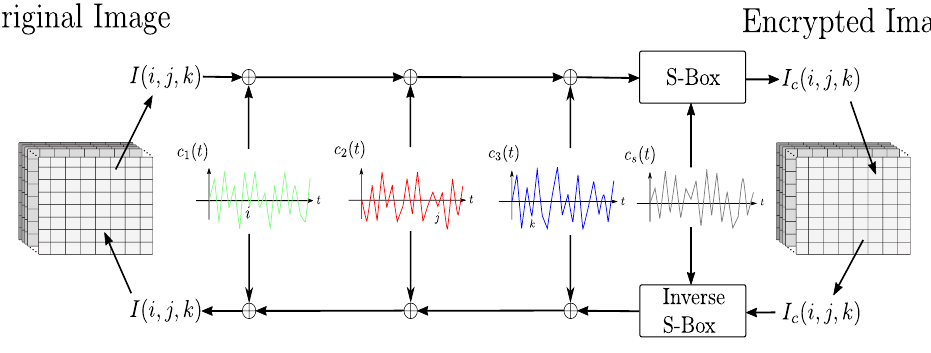
Figure 4. Chaotic Encryption